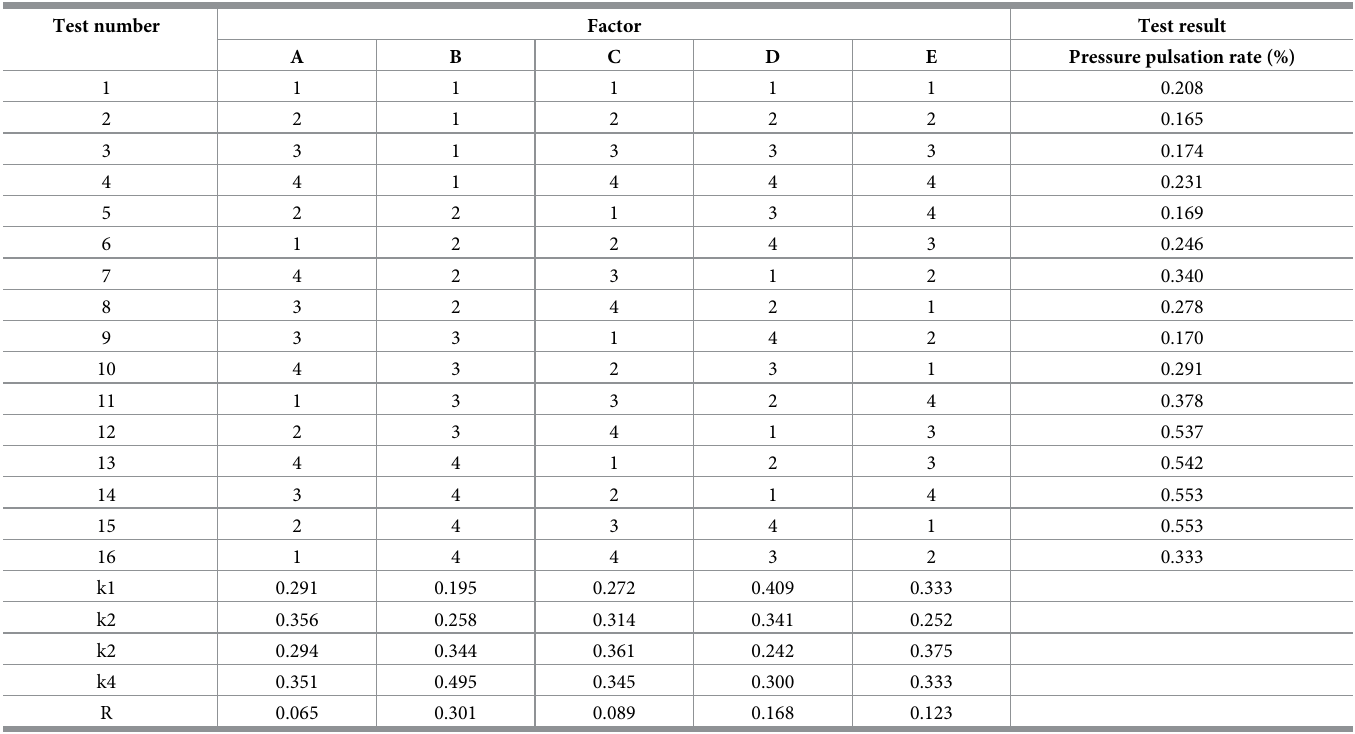
Table 8. Orthogonal test analysis table of pressure